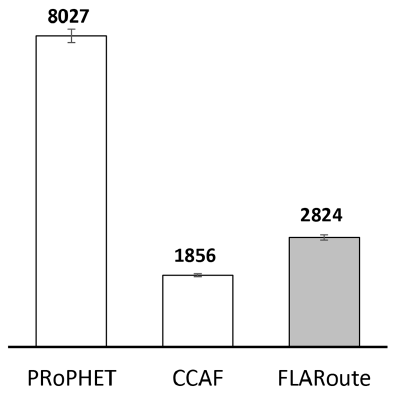
Figure 16. Number of failed transmissions (aka. “aborted messages” in the ONE simulator) recorded by PRoPHET, CCAF and FLARoute.